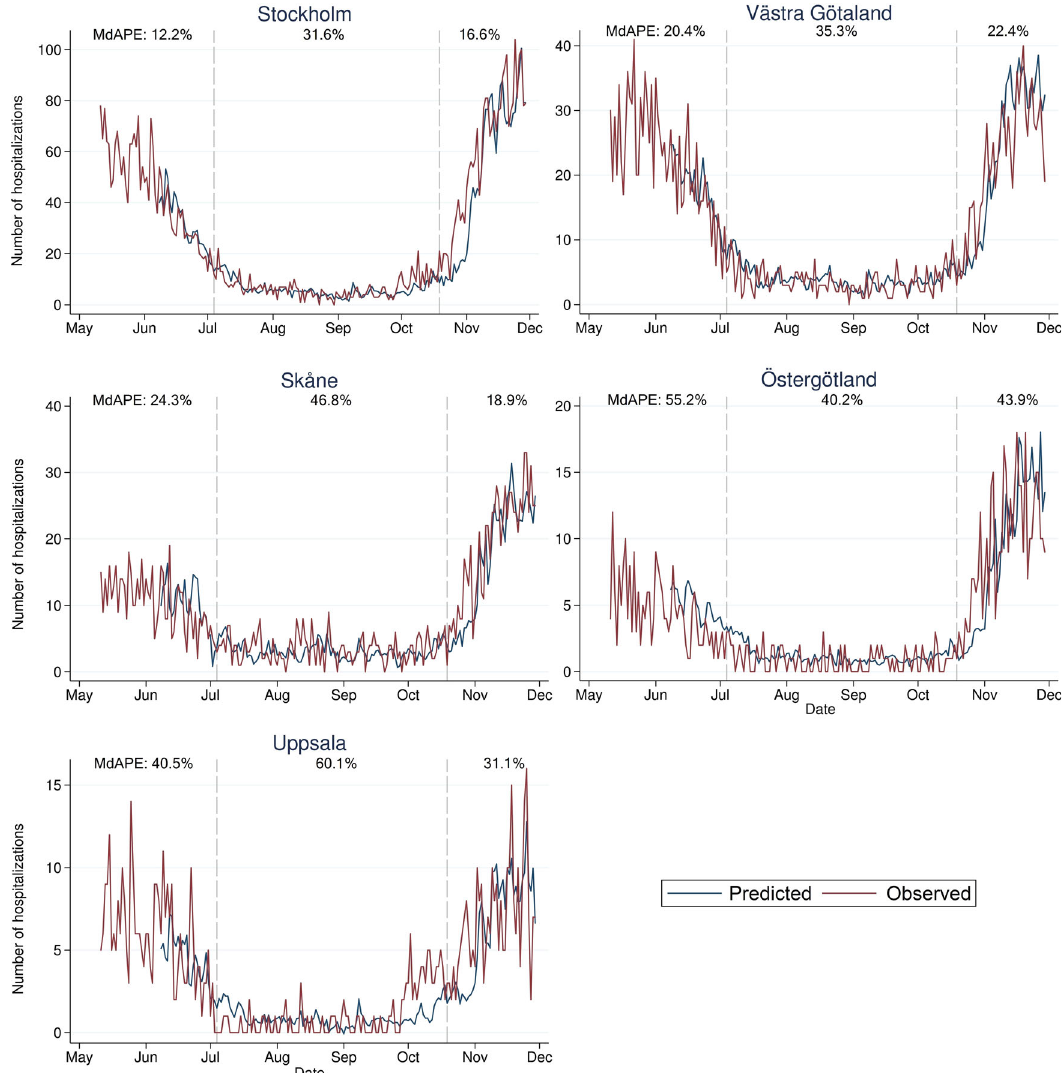
Fig. 4 Predicted number of daily hospital admissions in Sweden. Predicted number of daily hospital admissions 7 days ahead across the fi ve most populated regions in Sweden ordered by population size. The median absolute percentage errors (MdAPEs) of the predictions are denoted for the fi